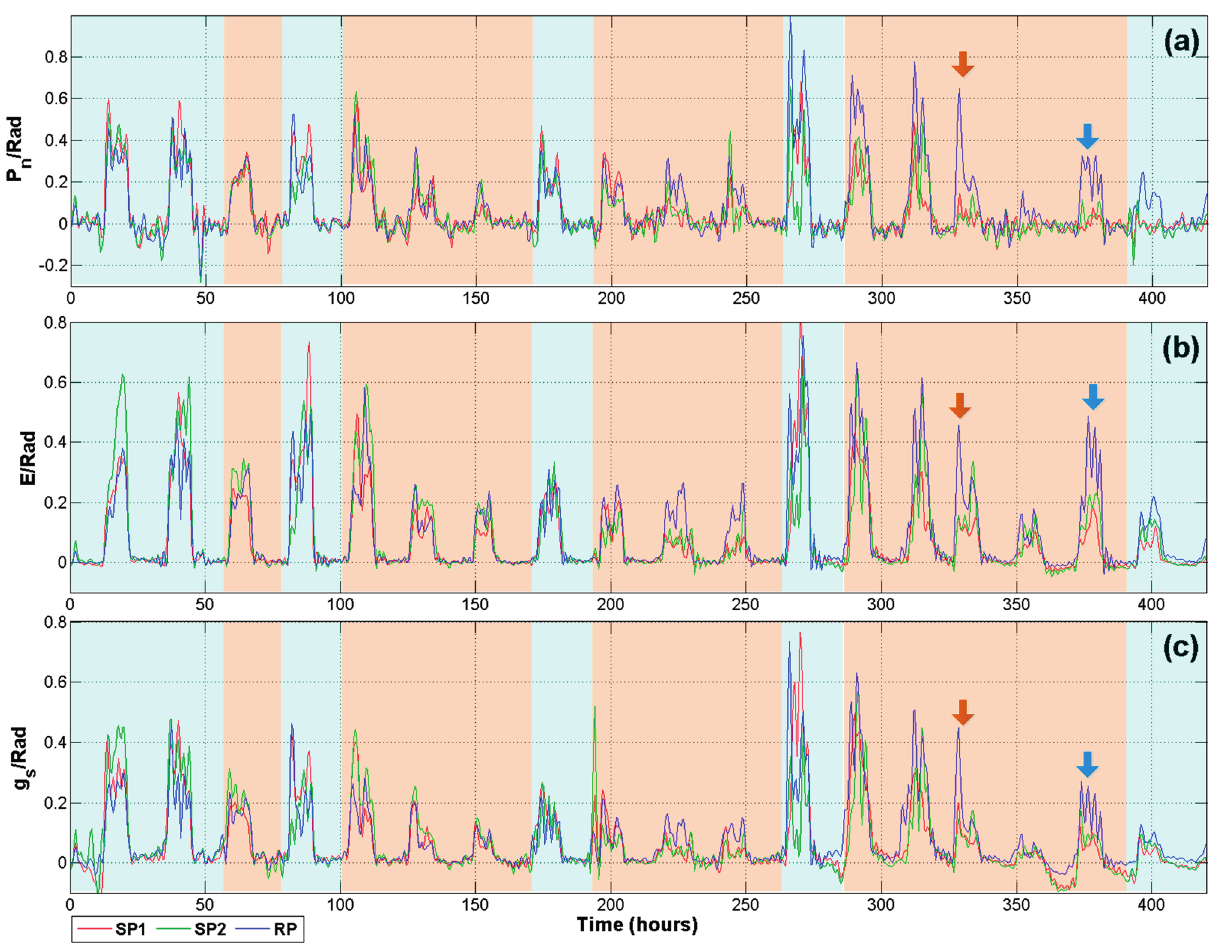
Figure 10. Wavelet of processes/Radiation indexes. ( a ) Photosynthesis; ( b ) transpiration; and ( c ) stomatal